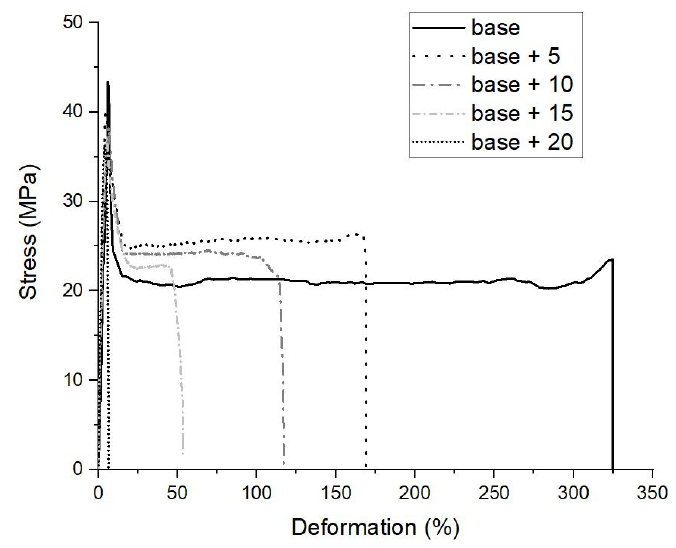
Figure 5. Stress-strain curves of the biocomposites.